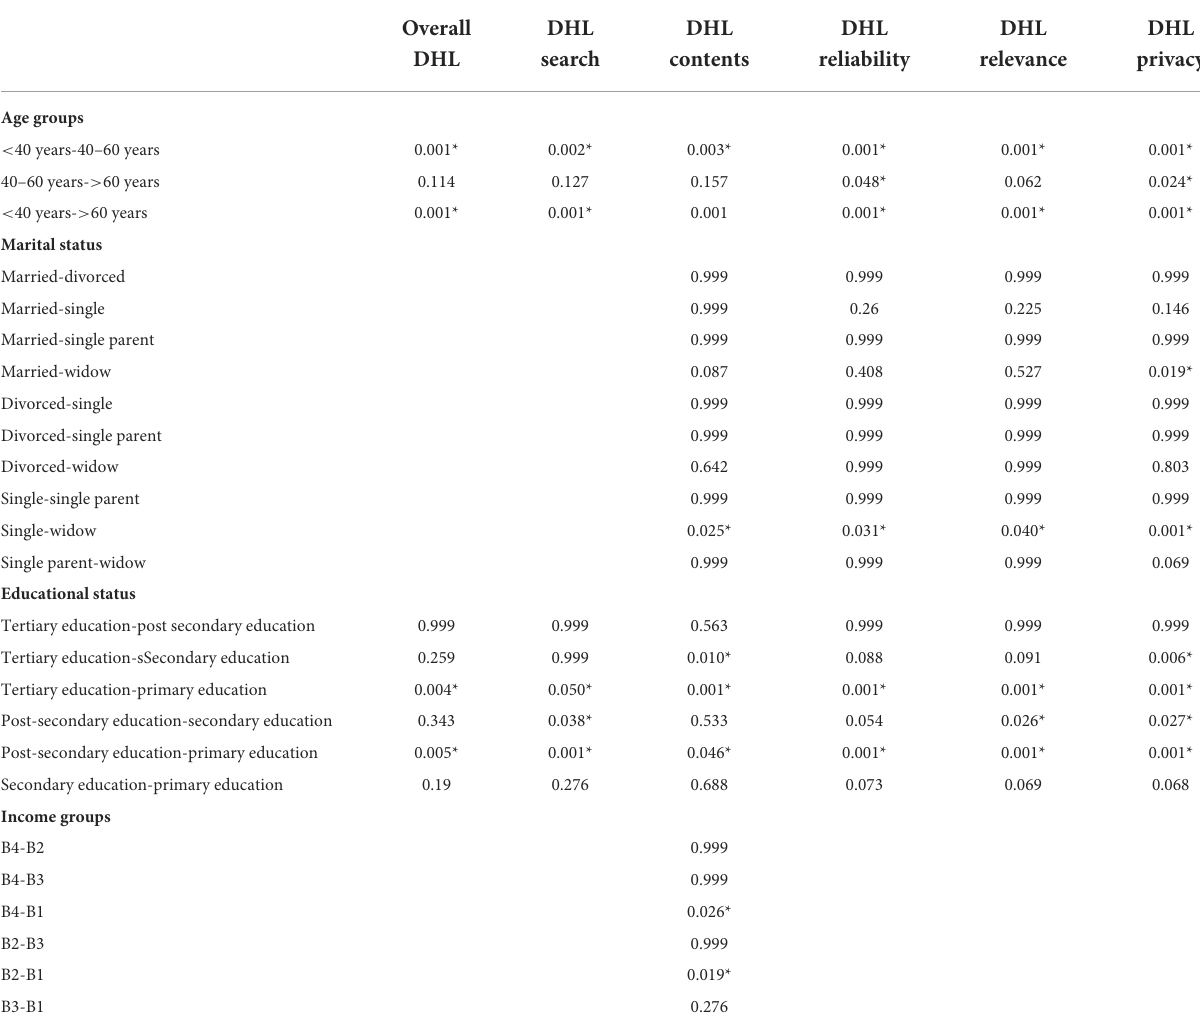
TABLE 3 Post-hoc analysis in Kruskal Walis